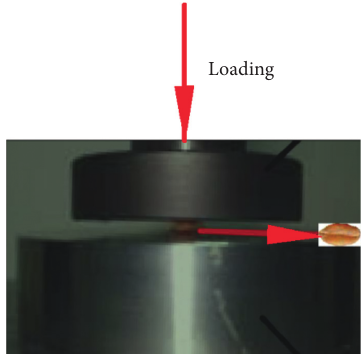
Figure 2: Schematic diagram of the force of the wheat uniaxial